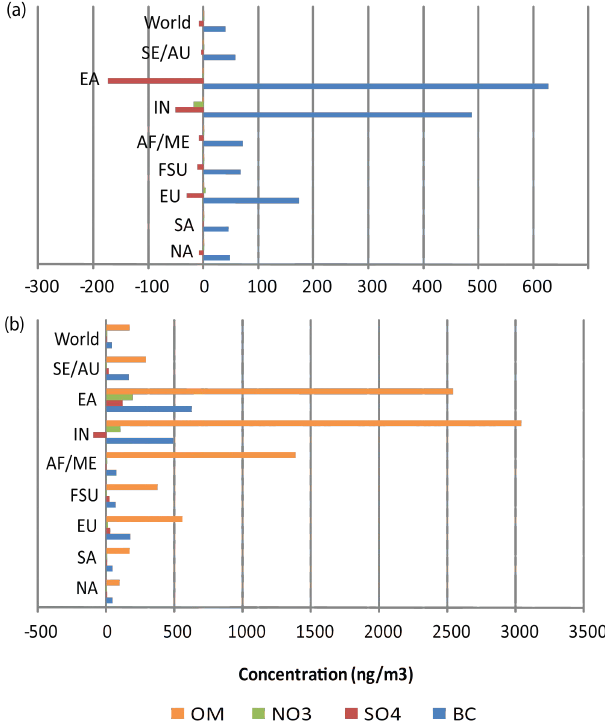
Fig. 5. Reduction in global and regional annual average concentra- tions (ngm − 3 ) of PM 2 . 5 species for halving global anthropogenic (a) BC emissions and (b) BC+OC emissions, relative to the base case. Negative values indicate increases.